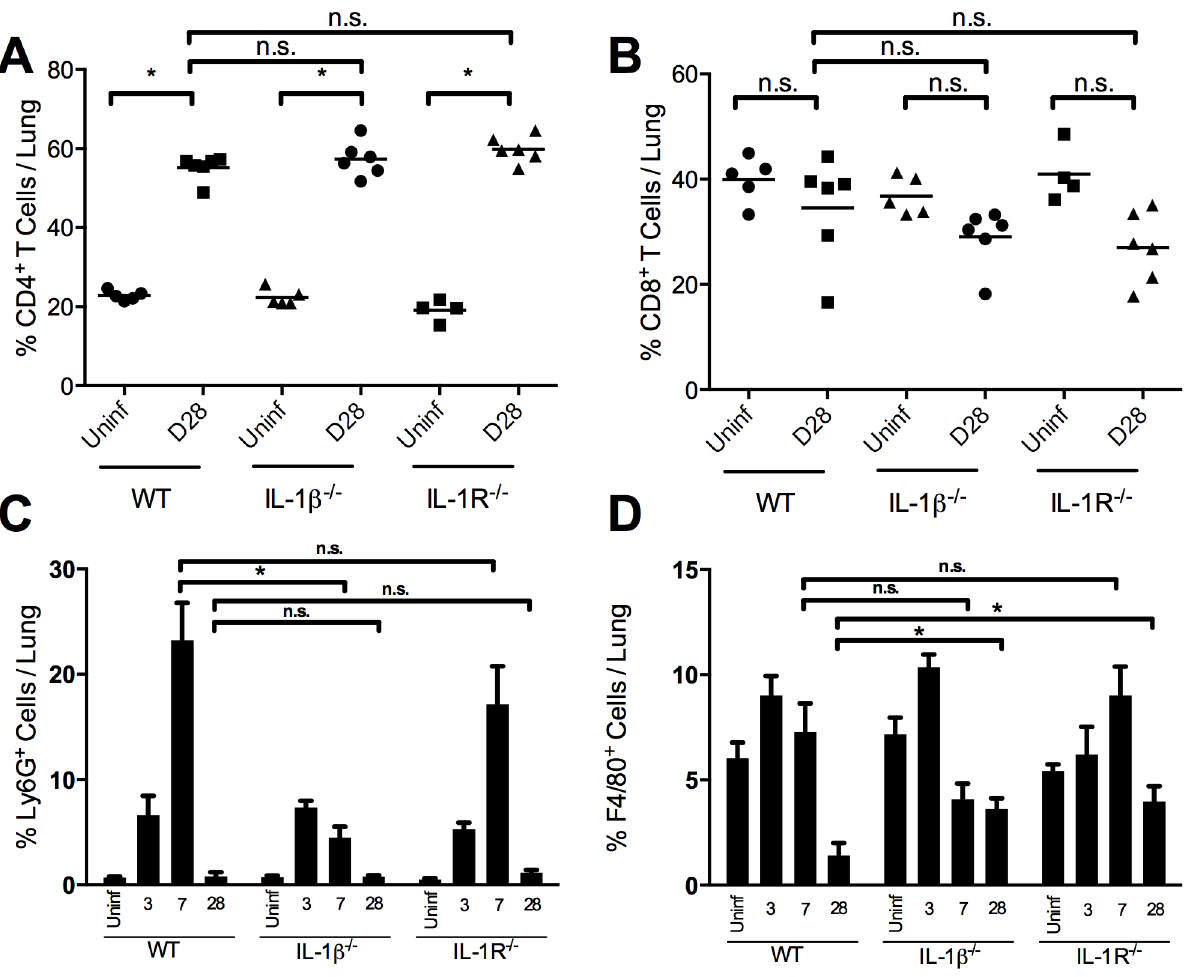
Figure 3. IL-1 is not required for recruitment of immune cells to the lung. Lungs were excised and made into a single cell suspension for flow cytometry at the indicated days post-inoculation. Cells were stained with anti-CD45 to identify hematopoietic cells and anti-CD11b, CD3, CD4, CD8, Ly6G, and F4/80 for further subsets. Gating for T cells subsets was performed on CD45 + CD3 + cells with quadrant gating to identify either (A) CD4 + or (B) CD8 + single-positive T cells. Gating on CD45 + CD11b + cells, (C) Ly6G + neutrophils or (D) F4/80 + macrophages were identified. Data was collected with a BD LSRII flow cytometer. Bars indicate the mean percentage of each group (n=6) with (*) indicating p , 0.05 using the Kruskal-Wallis test with Dunn’s post-hoc test for multiple